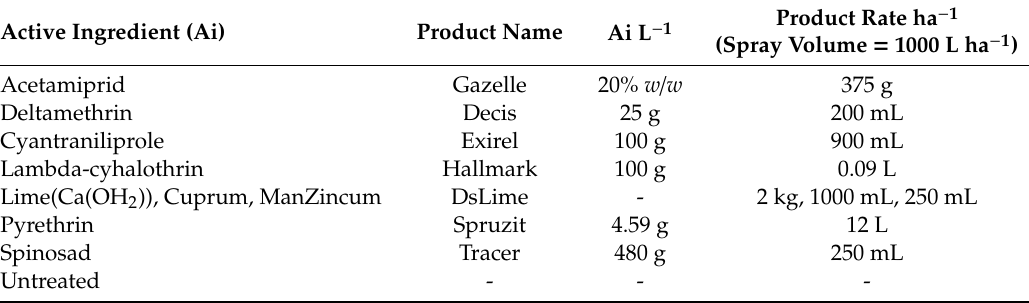
Table 1. Plant protection products applied to cv. Penny trees in the e ffi cacy and longevity test in an experimental orchard at NIAB